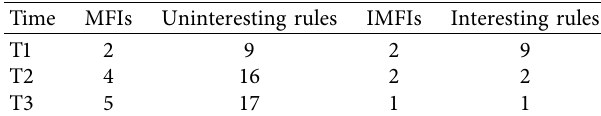
Table 11: Results of the example at times T1, T2, and T3. Time